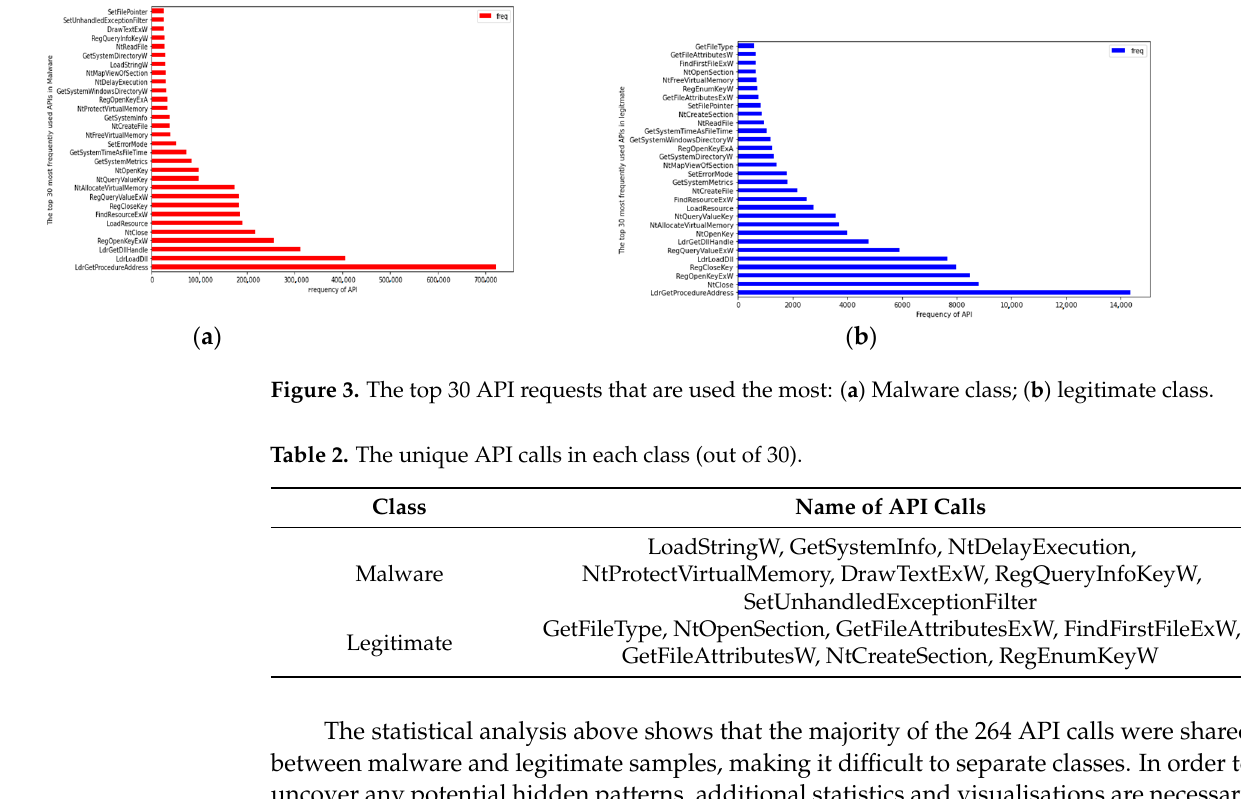
Figure 2. The unique API calls of malware class.